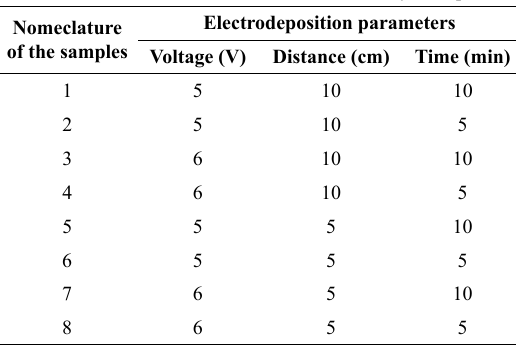
Table 2. Parameters for black chromium electrolytic deposition Electrodeposition parameters Nomeclature of the samples